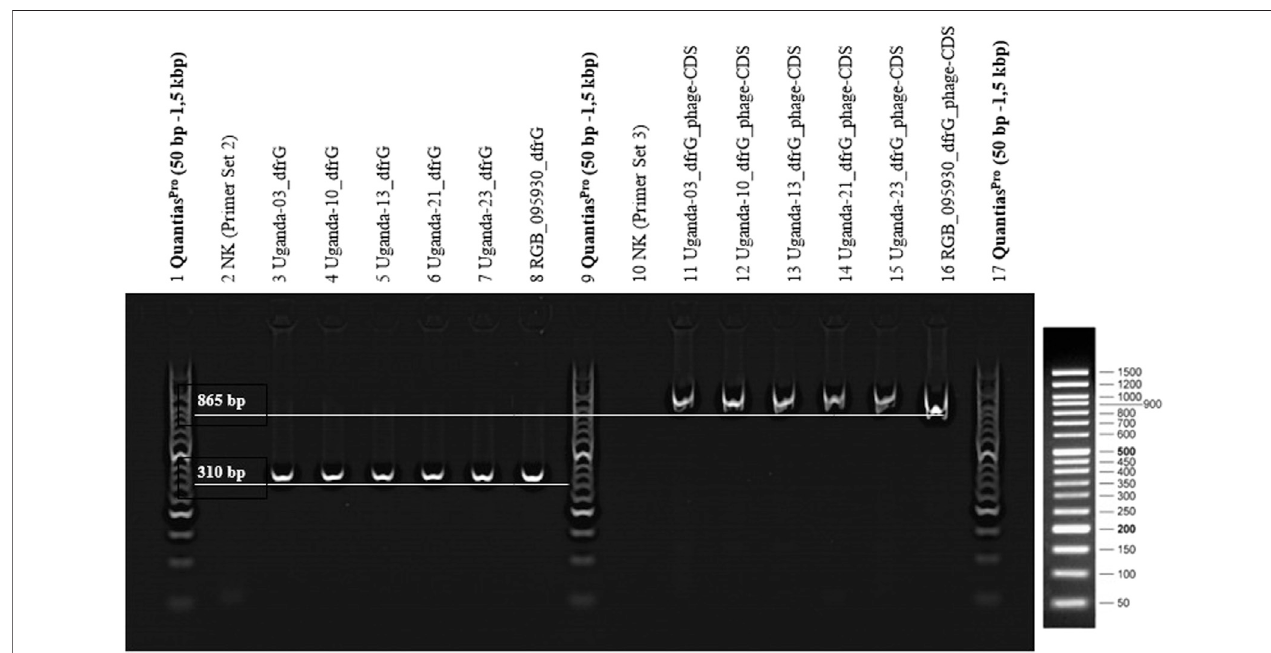
FIGURE 6 | 2% agarose gel (TBE-buffer/GelRed 1:10,000), 1x LoadingDye (Qiagen), Quantias Pro DNA Marker (50 bp-1.5 kbp), 100 V, 45 min. PCR products of primer set A, for the detection of dfrG (lane 2-8) and primer set B, for the detection of dfrG in the phage genome (lanes 10-16).